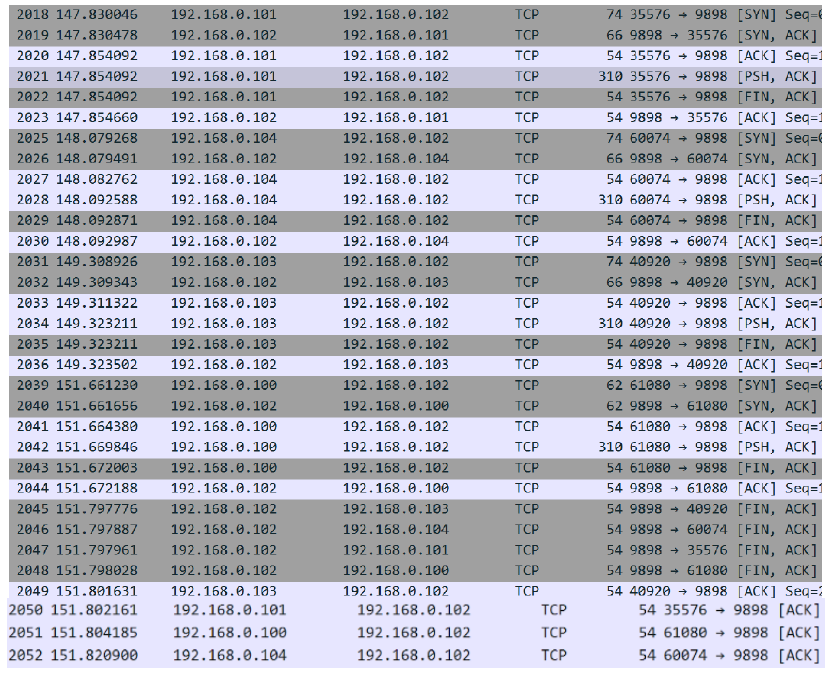
Figure 22. Final responses to the block creator (192.168.0.102) Wireshark network traffic.